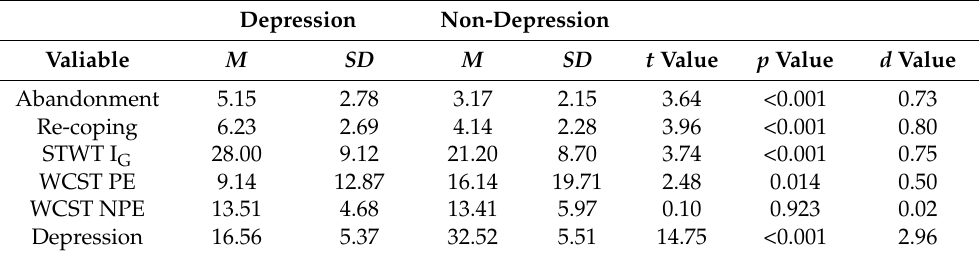
Table 1. Means of all variables in each variable between participants with depression ( n = 171) and those with non-depression ( n =